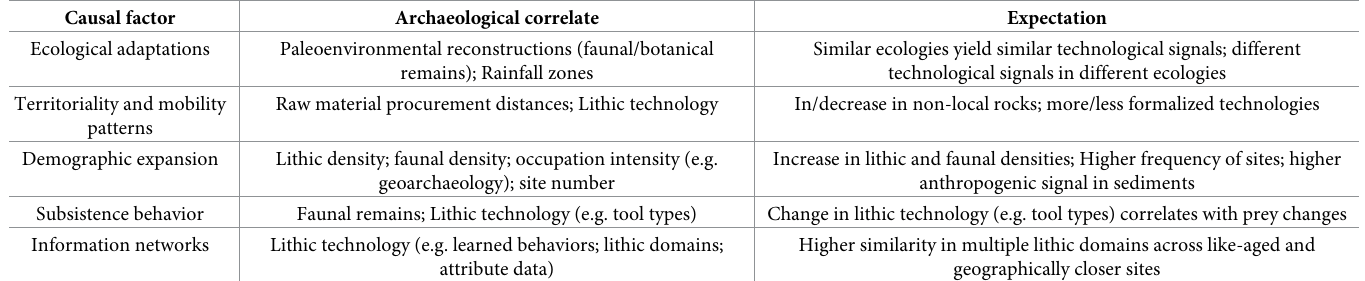
Table 1. Proposed causal factors for changes in southern African MSA lithic technology, their archaeological correlates and